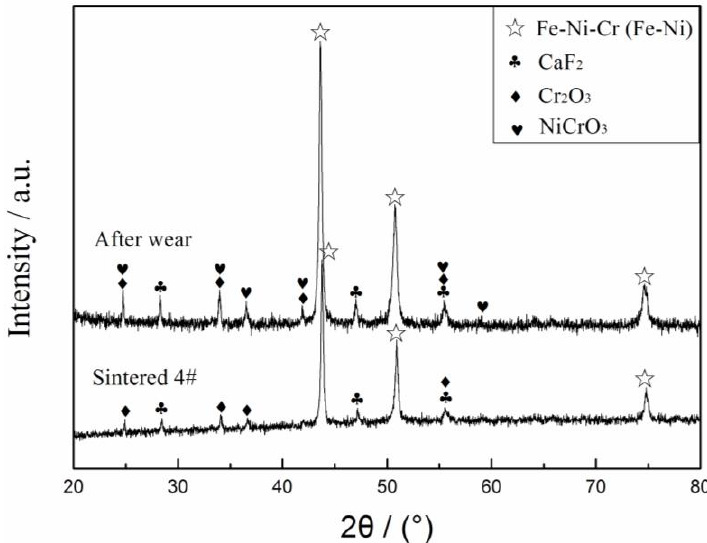
Figure 5. X-ray diffraction patterns of sample 4#.